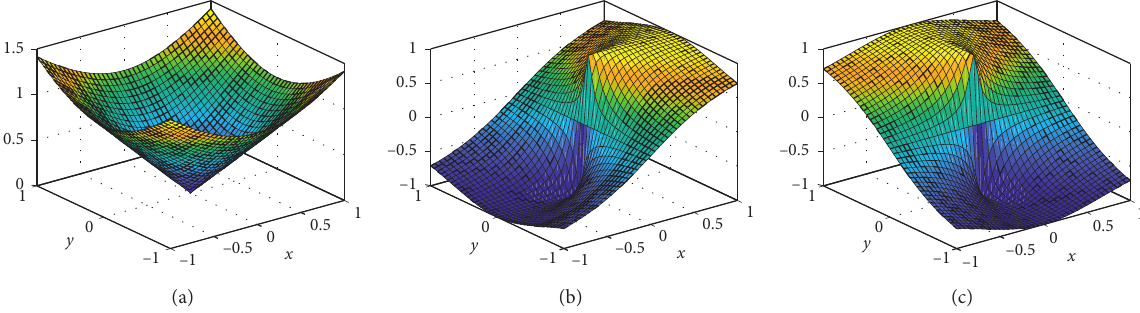
( x ) , (b) z g ( x ) / z x , and (c) z g i i